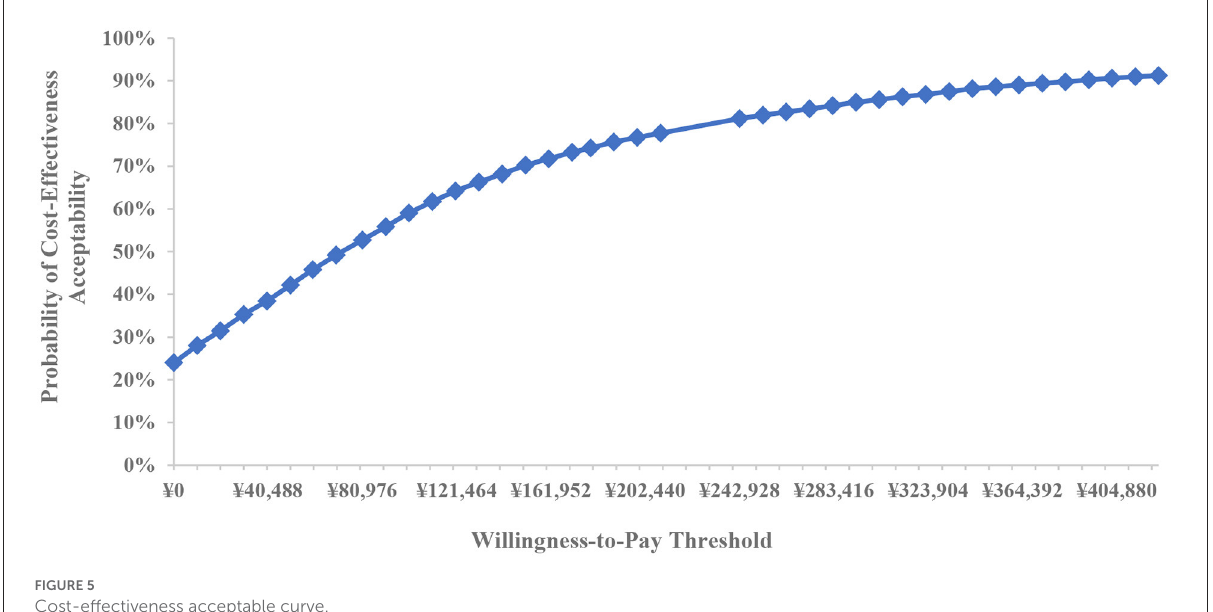
FIGURE5 Cost-effectiveness acceptable